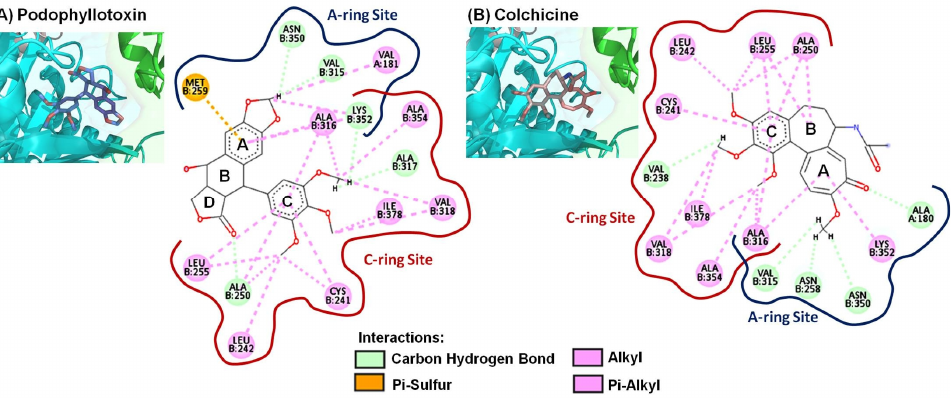
Figure 4. Close-up of ( A ) podophyllotoxin and ( B ) colchicine within the colchicine-binding site of the αβ -tubulin shown along with their corresponding 2D interaction plots.